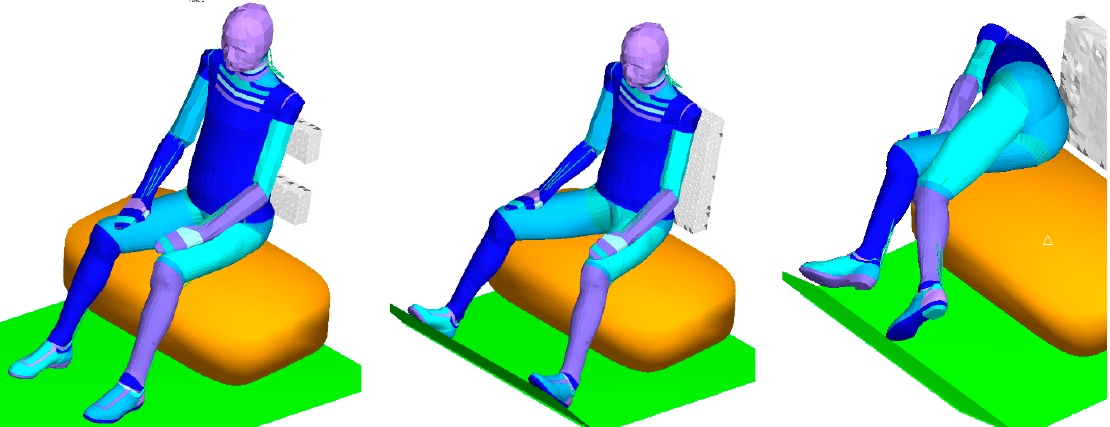
Figure 1. Human model in the vibration test on an experimental seat with a configurable backrest and two foam blocks modelled using finite elements ( left ) and on the rear bench of a Prius vehicle in the slalom test ( middle ) and falling without leg control in the slalom ( right ).